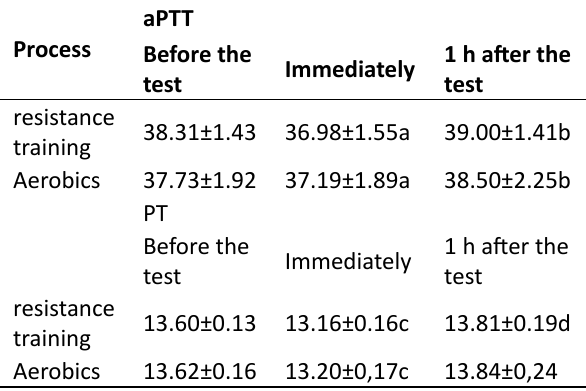
Table 1. Mean and standard deviance aPPT and PT